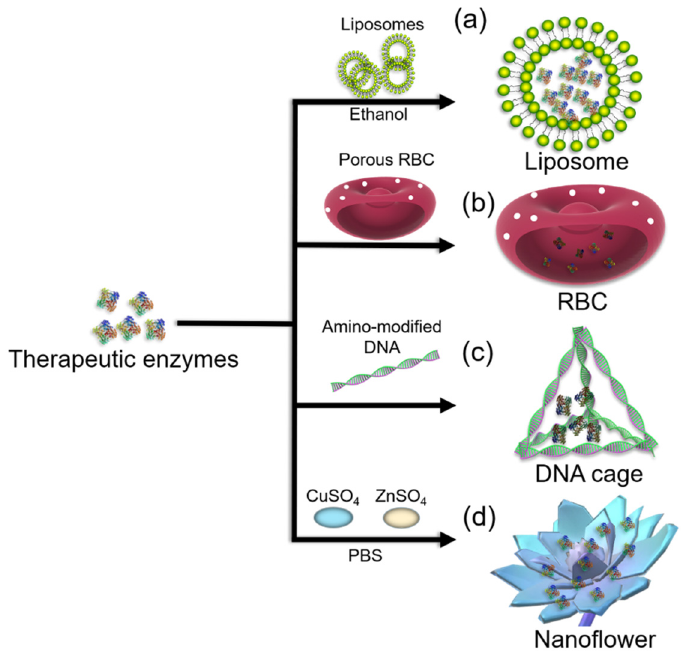
Figure 2. Illustration of entrapment approaches for therapeutic enzyme immobilization using ( a ) liposomes, ( b ) red blood cells (RBCs), ( c ) DNA cages, and ( d ) metal–protein hybrids (nanoflowers). Here, PBS denotes phosphate-buffered saline.